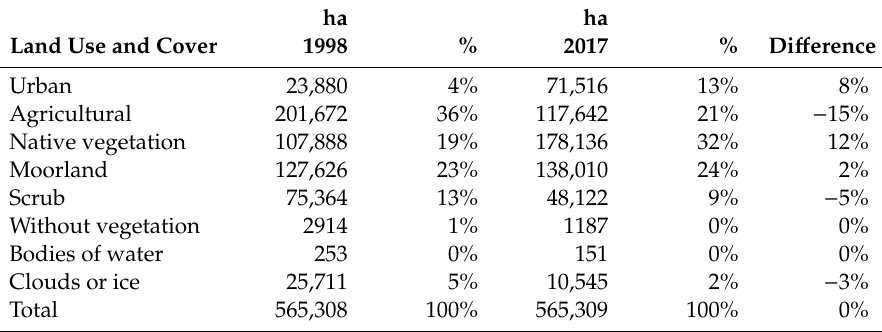
Table 2. Land use and land cover in the New Metropolitan Area of Quito (NAMQ), 1998 and 2017. ha ha Land Use and